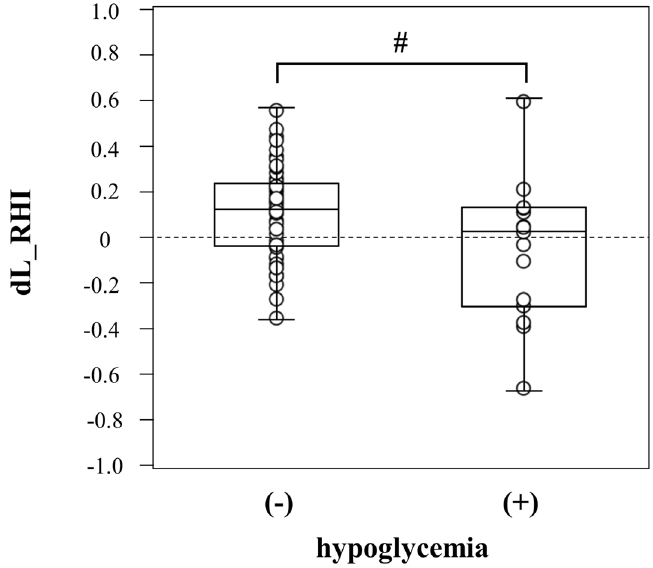
Figure 1. Changes in endothelial function in patients with and without hypoglycemia. # p < 0.05. L_RHI, natural logarithmically scaled reactive hyperemia